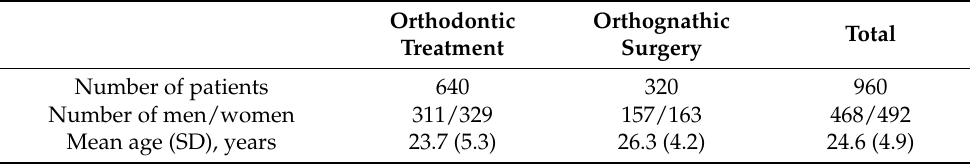
Table 1. Demographic characteristics of the samples used in this